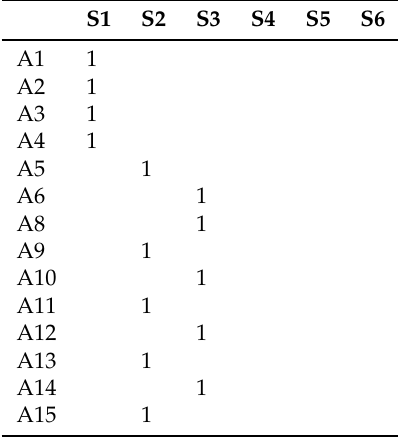
Table 6. Activity–skill matrix that defines which skills are required to perform a given